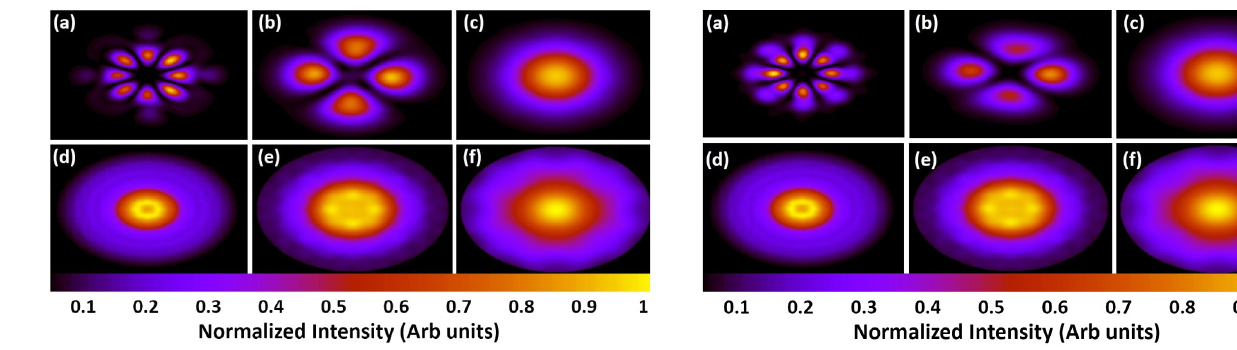
FIG. 10. Mode profiles from our analytic model with an outcoupling hole size of 4 mm, for the intermediate configuration ( g ¼ − 0 . 6 ) at wavelengths of (a) 10 μ m, (b) 25 μ m and (c) 50 μ m, and for the concentric configuration ( g ¼ − 1 ) at wavelengths of (d) 10 μ m, (e) 25 μ m and (f) 50 μ m. For each plot the window size is 50 mm by 50